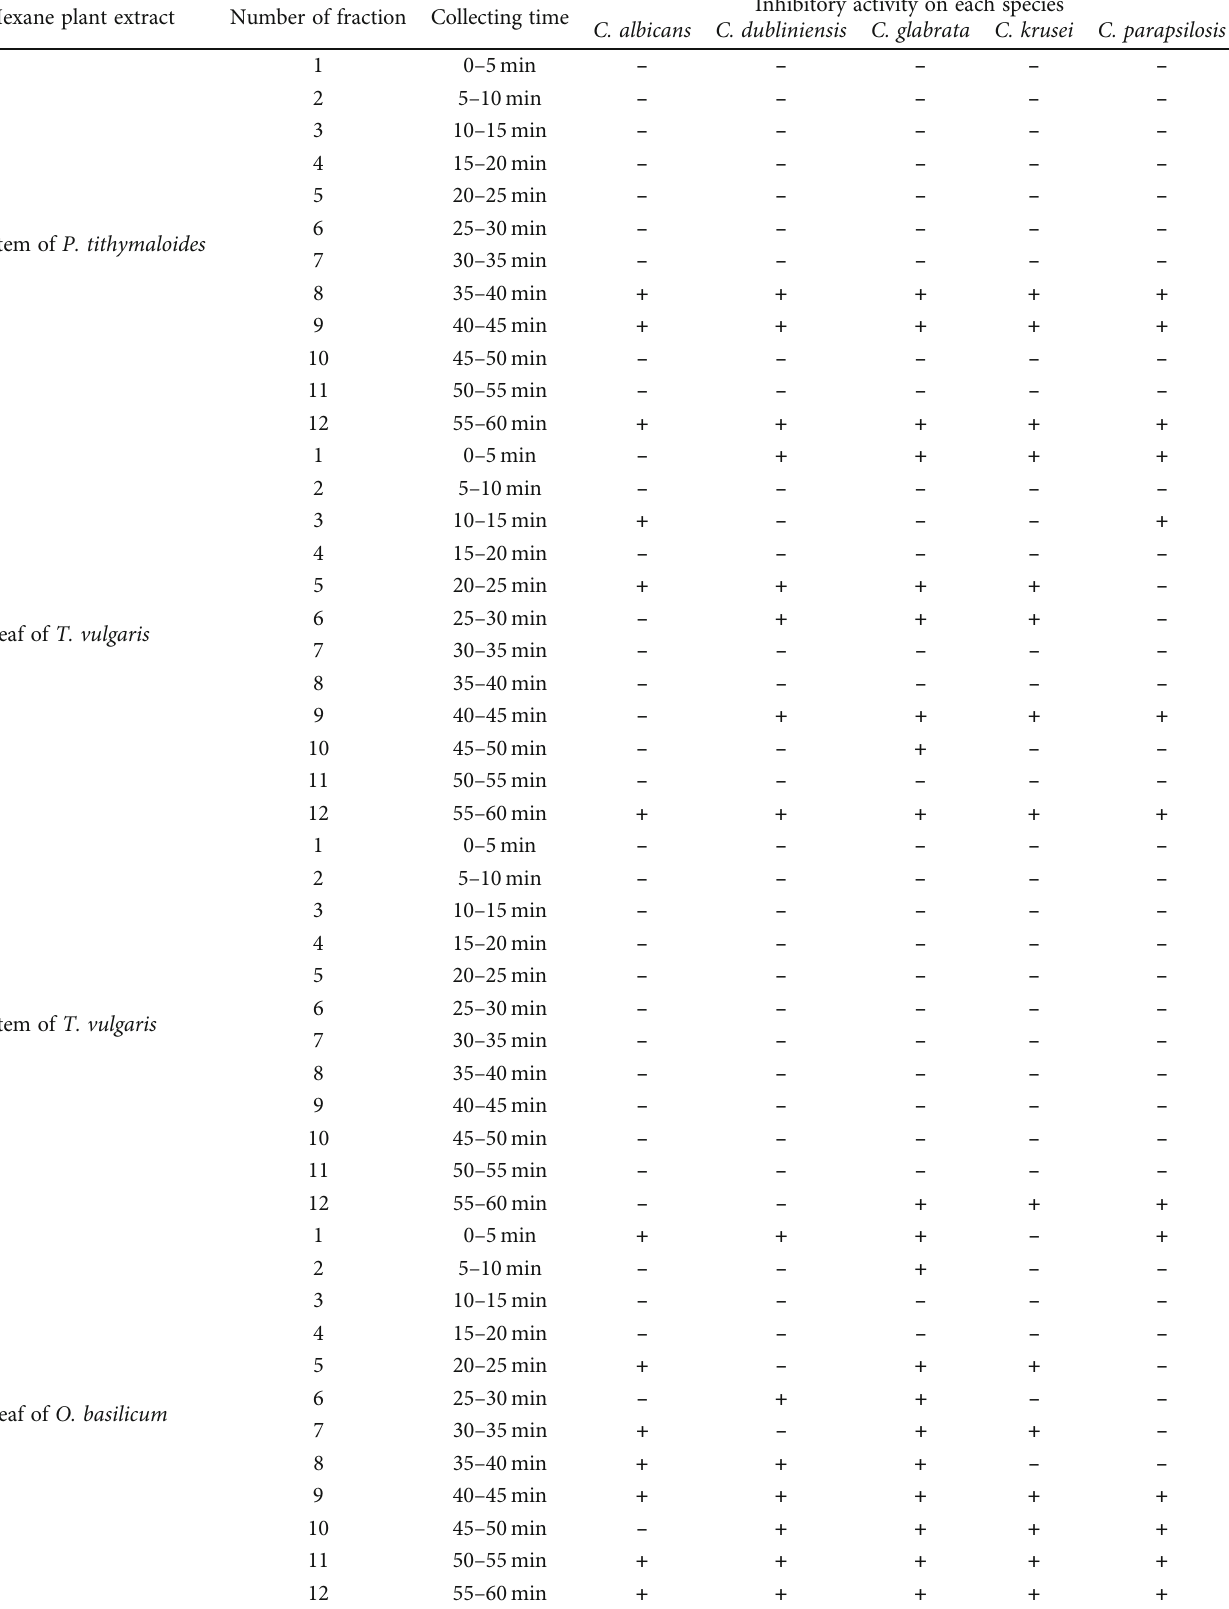
Table 2: Susceptibility assays with the HPLC obtained